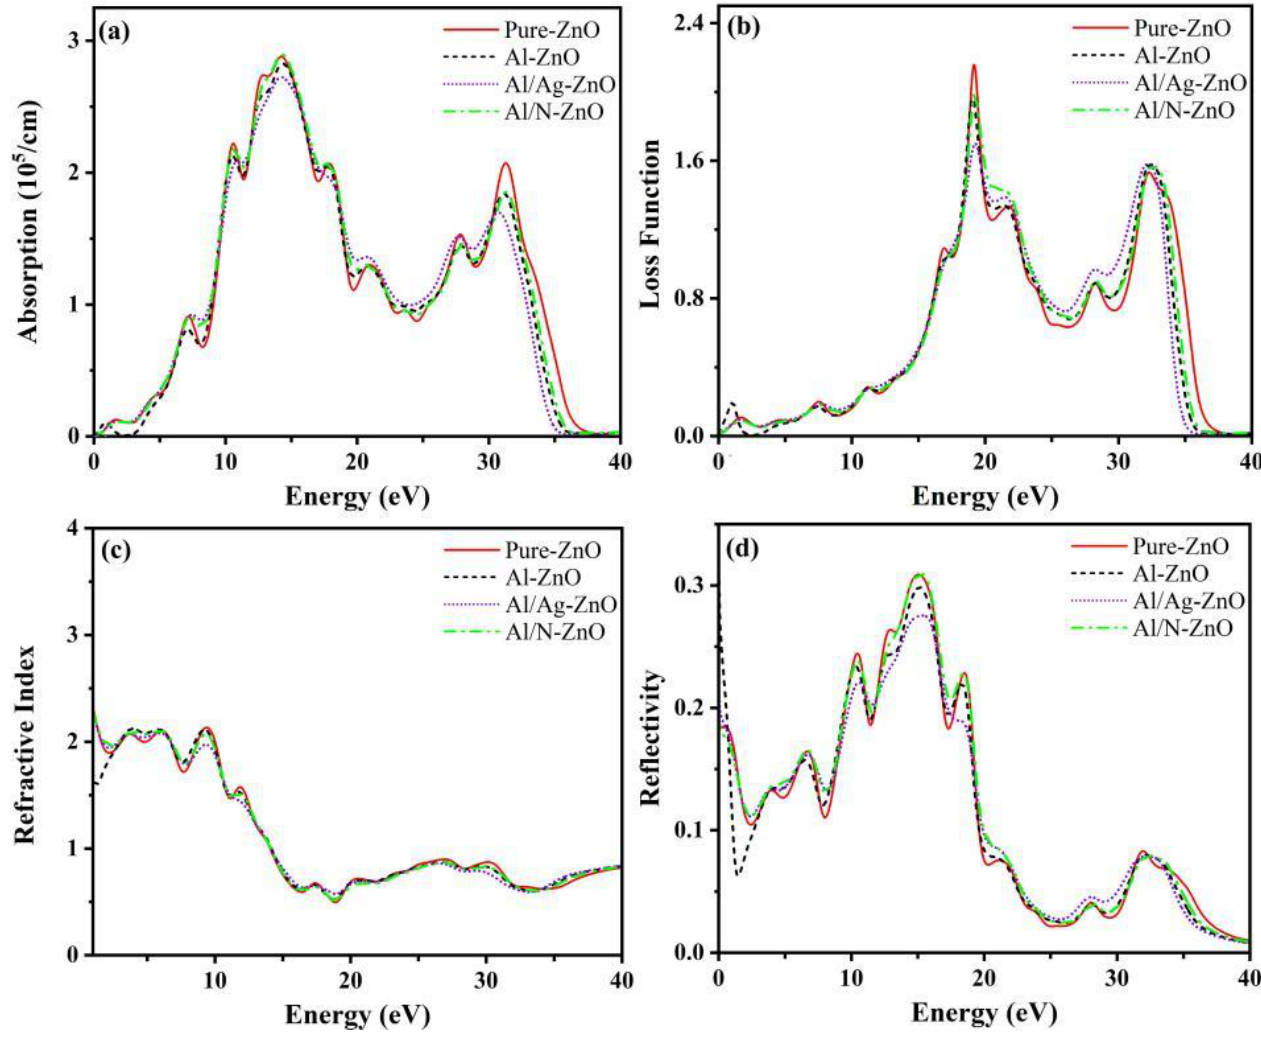
Figure 6. Optical constants of doped ZnO, including absorption ( a ), loss function ( b ), refractive index ( c ), and reflectivity ( d ).